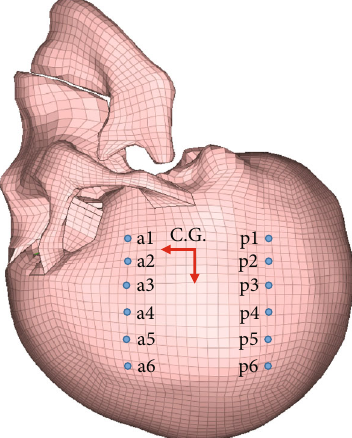
Figure 2: Schematic diagram of head centroid and